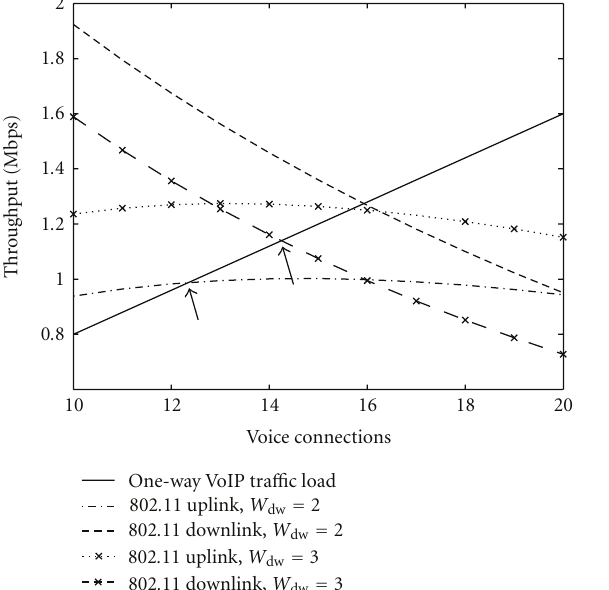
Figure 7: The throughput performance for our proposed scheme using priority and collaboration.